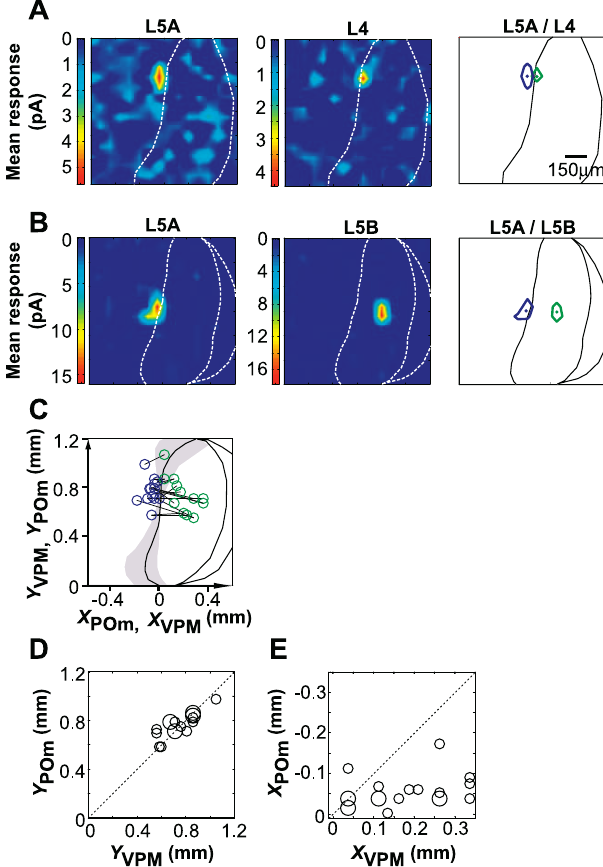
Figure 6. Somatotopic Maps in VPM and POm (A) Synaptic input maps (left) for a pair of L5A and L4 cells recorded in the same barrel-related column, and the overlaid input domains (right). Circles indicate the position of the largest responses in the input domains. (B) Same as (A) for a pair of L5A and L5B cells. (C) Positions of the centers of POm (blue) and VPM (green) input domains for pairs of cells recorded in the same column. (D) and (E) Distances of the centers of the input domains from the bottom of VPM ( Y POm , Y VPM ; [D]) and from the POm/VPM boundary ( X POm , X VPM ; [E]) for pairs of cells recorded in the same column (coordinate system is indicated in [C]). Larger symbols indicate overlay of multiple pairs (L5A/L4, n ¼ 13; L5A/L5B, n ¼ 5; L5A/L6A, n ¼ 2). Dashed lines indicate the predicted relationships if VPM and POm somatotopy was mirror symmetric. DOI: